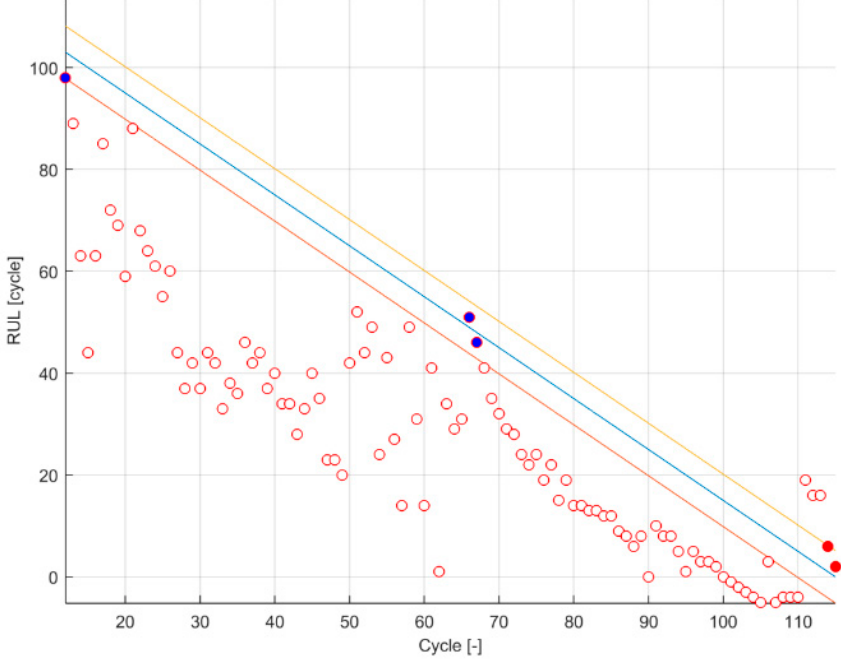
Figure 5. Results from test nº 1 (“B0007” linearly modelled).